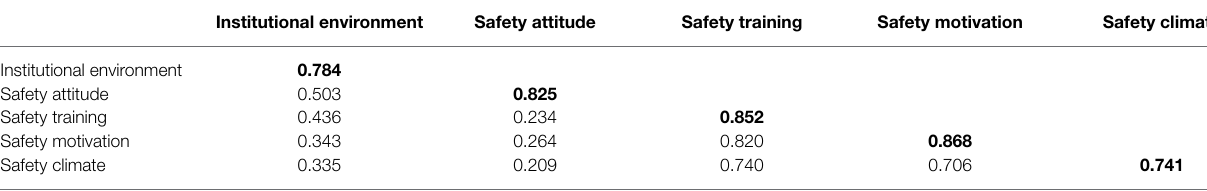
TABLE 6 | Anchors of the set and calibration.